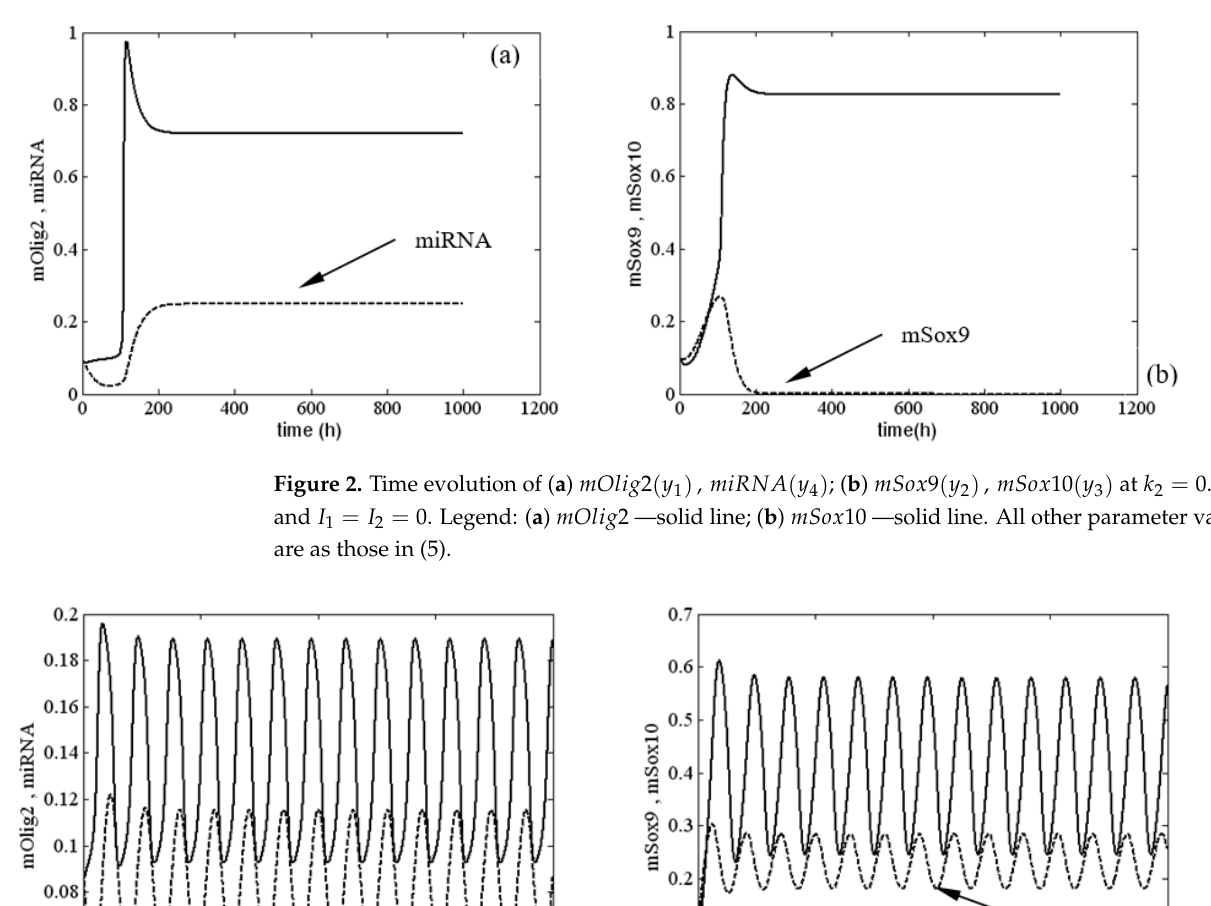
Figure 3. Sustained oscillations of system (1) at k 2 = 0.085, I 1 = 0.1 and I 2 = 0.02. Legend: mOlig 2 —solid line ( left panel ); mSox 10 —solid line ( right panel ). All other parameter values are as those in